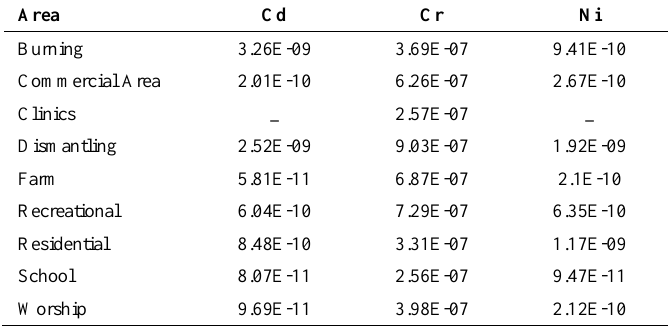
Table 4. Carcinogenic hazard indices of heavy